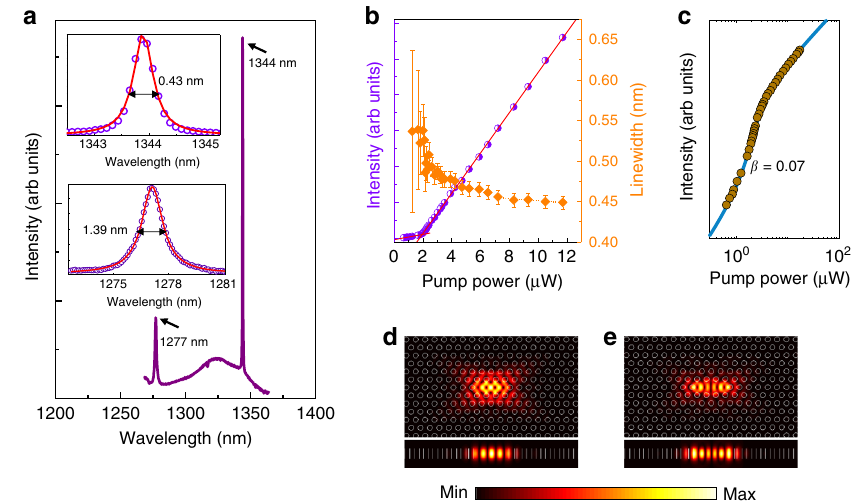
Fig. 5 Lasing performance with different structural parameters. a Collected lasing spectrum above threshold of a fabricated PC laser with lattice constant a = 315 nm and radius r / a = 0.27. The inset shows the magni fi ed PL spectra of the lasing peak at 1344 nm and the resonant peak at 1277 nm with the pumping power 20 μ W. b Corresponding collected intensity and linewidth as a function of input pumping powers for the emission peak at 1344 nm with lasing threshold at 1.9 μ W. The error bars express standard errors deduced by fi tting. c Corresponding logarithmic L – L plot of the PC laser, and the blue line was theoretically obtained results by using rate equation analyses. d , e present the top-view and cross-section view of the calculated E- fi eld pro fi les for the fundamental mode (1344 nm) and the fi rst higher order mode (1277 nm),